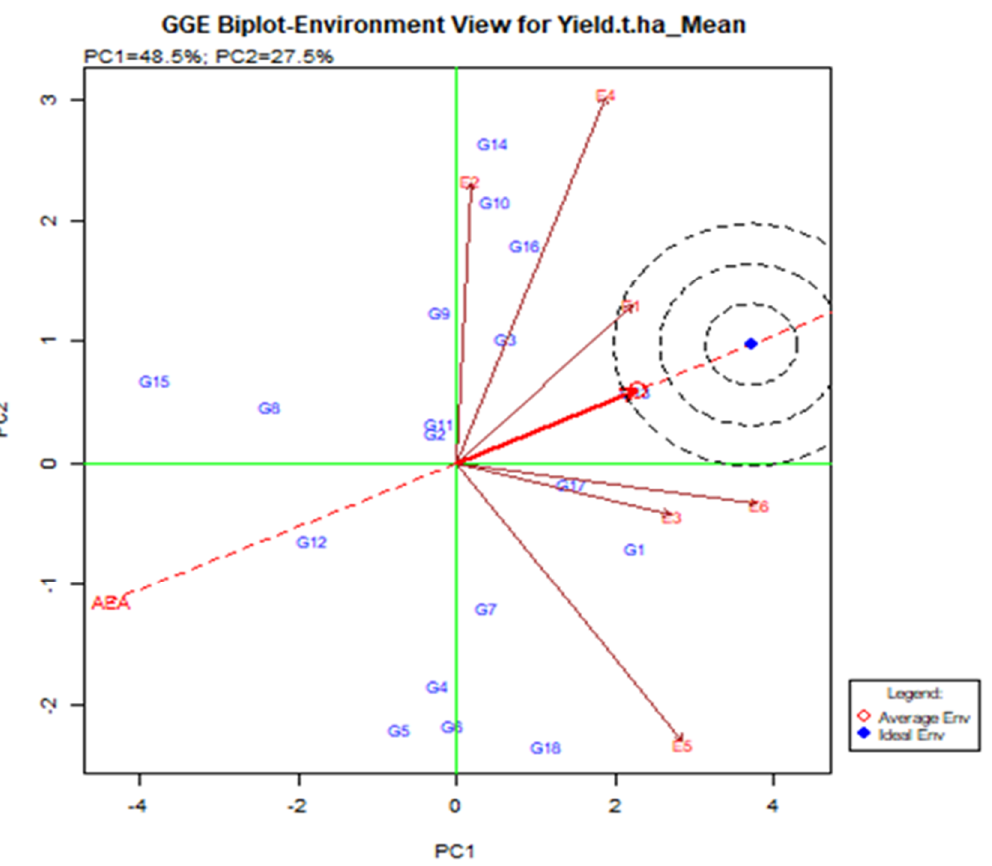
Figure 5. Relationship among the test environments constructed on the average environment axis (AEA), regarding stability and adaptability of elite rice genotypes for grain yield estimated over six environments.